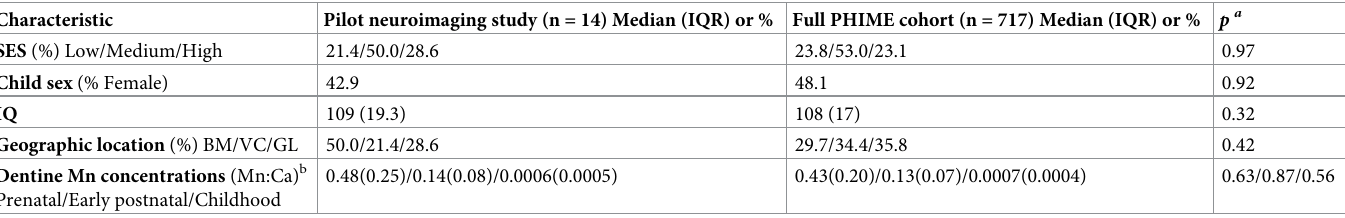
Table 1. Demographic and exposure characteristics of the participants of the pilot resting state fMRI study described here (n = 14) and of the PHIME cohort study participants who were not included in the pilot resting state fMRI study (n = 717).